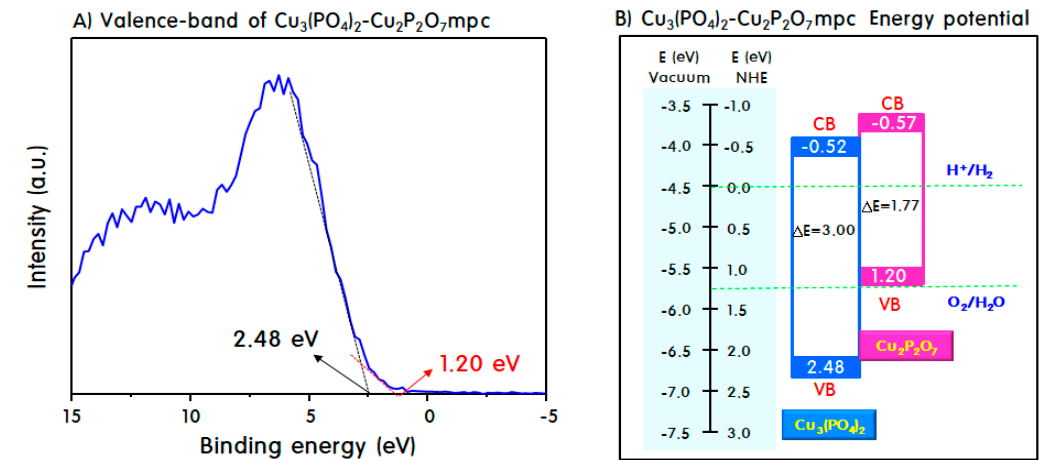
Figure 8. ( A ) VB spectra determined from the XPS study of H 2 and O 2 over M 3 (PO 4 ) 2 -M 2 P 2 O 7 mpc (M = Co, Ni, Cu) and ( B ) electron transfer energy diagram for M 3 (PO 4 ) 2 -M 2 P 2 O 7 mpc (M = Co, Ni, and Cu).